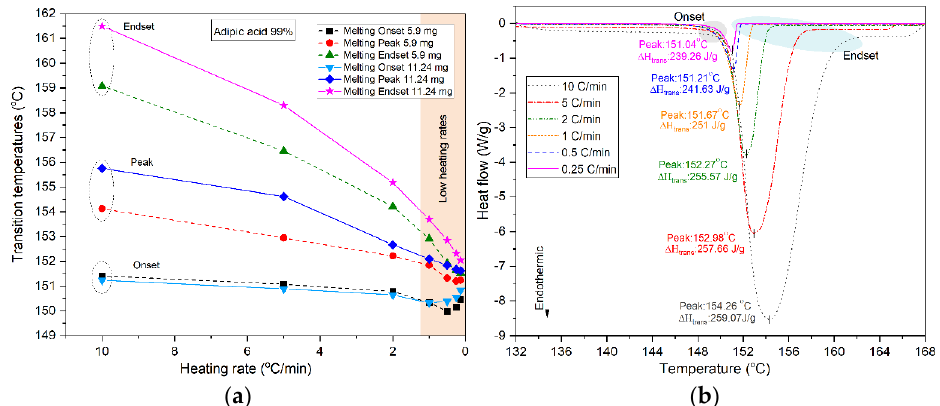
Figure 10. The effect of ( a ) heating rates and sample mass on the transition temperature; ( b ) increasing the melting range with increasing heating rates for adipic acid (personal data). Table 6. Studies on the transition temperature of PCMs.